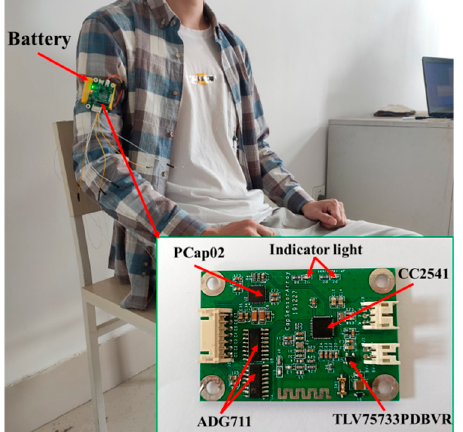
Figure 11. The actual image and installation position of the hardware circuit board.